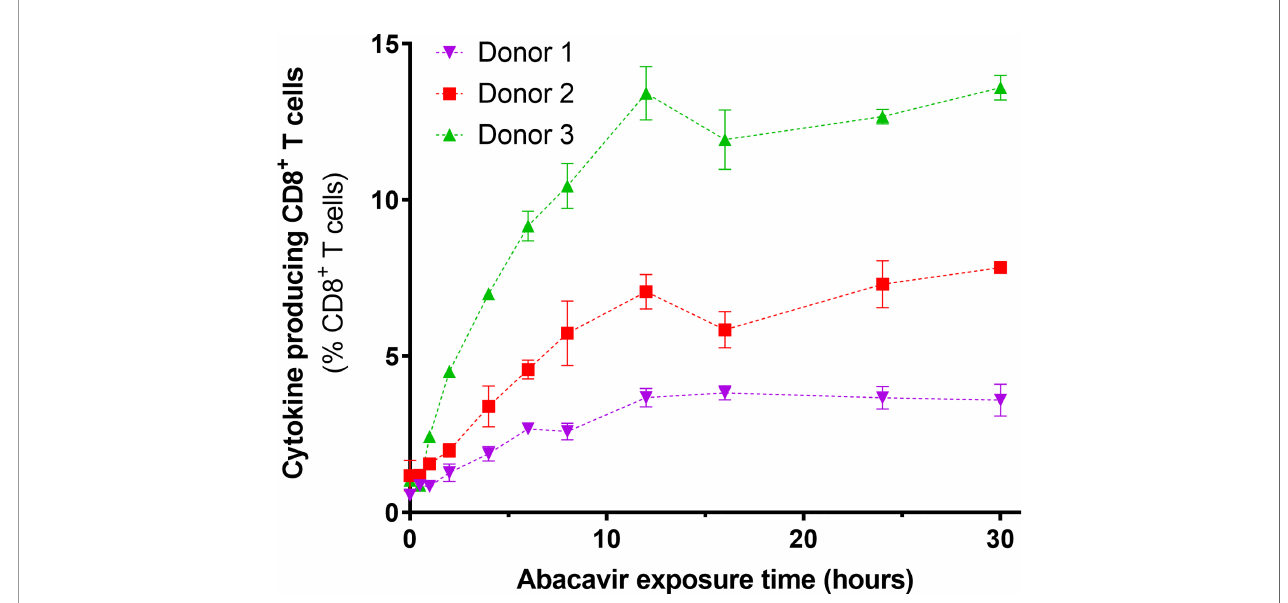
FIGURE 3 | Immunogenicity of HLA-B*57:01+ antigen presenting cells increases with abacavir exposure time. C1R.B*57:01 cells were cultured in 35 µM abacavir for 0 – 30 h prior to fi xation in paraformaldehyde. Immunogenicity was then gauged by their ability to stimulate cytokine (IFN g and/or TNF) production in CD8 + abacavir responsive T cells during a 6 h stimulation assay, detected via intracellular cytokine staining. Responses from T cell lines derived from three different HLA-B*57:01 + donors are shown. Donor 1 T cells were assayed in triplicate, whilst donor 2 and 3 T cells were assayed in duplicate in a separate experiment (mean +/ −